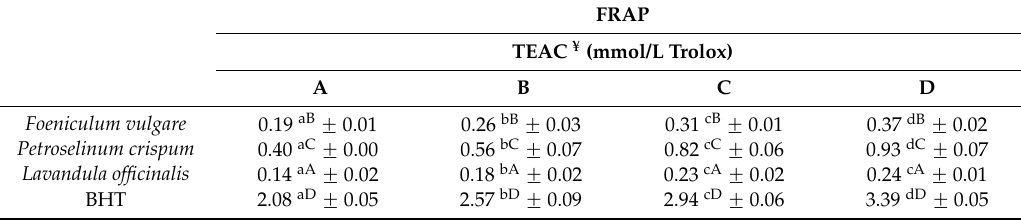
Table 4. Antioxidant activity of fennel, parsley, and lavender essential oils using the corresponding concentrations (A = 5 g/L, B = 10 g/L, C = 20 g/L, D = 50 g/L) measured by FRAP method.